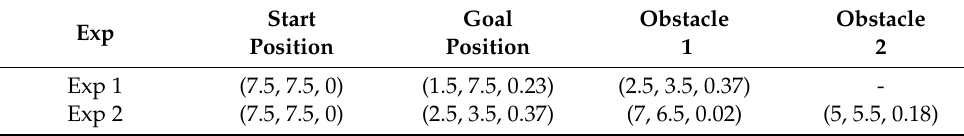
Table 3. Two experimental